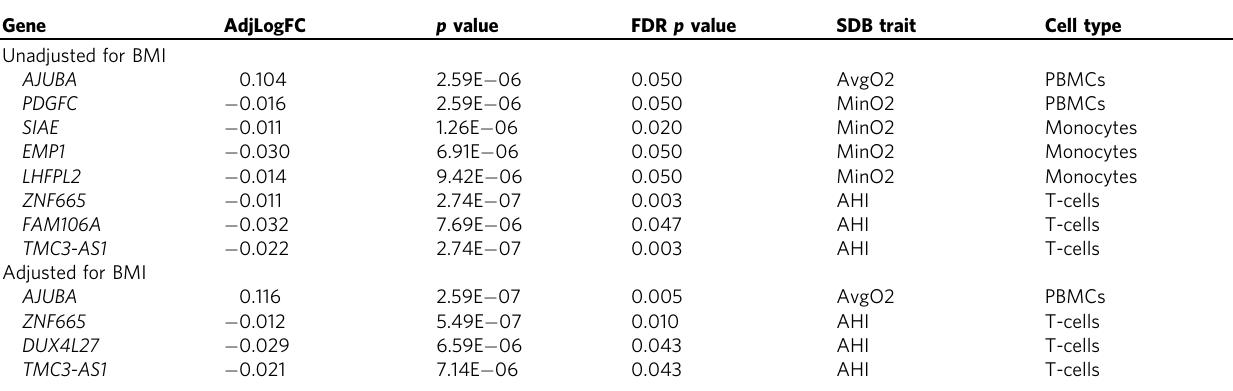
Table 1 Top results from the tissue-speci fi c transcriptome-wide gene expression analysis of SDB phenotypes (FDR p < 0.05) in MESA. Gene AdjLogFC p value FDR p value SDB trait Cell type Unadjusted for BMI AJUBA